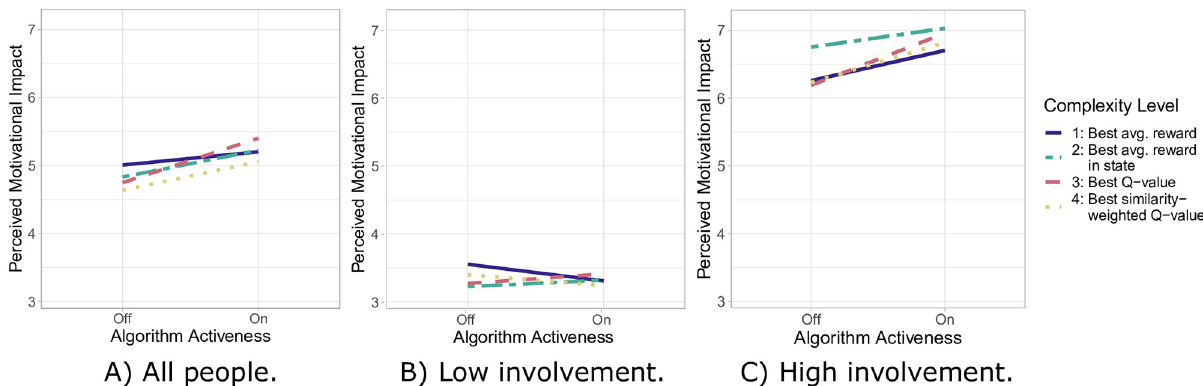
Fig 5. Mean perceived motivational impact when the algorithms are off/on per algorithm complexity level.